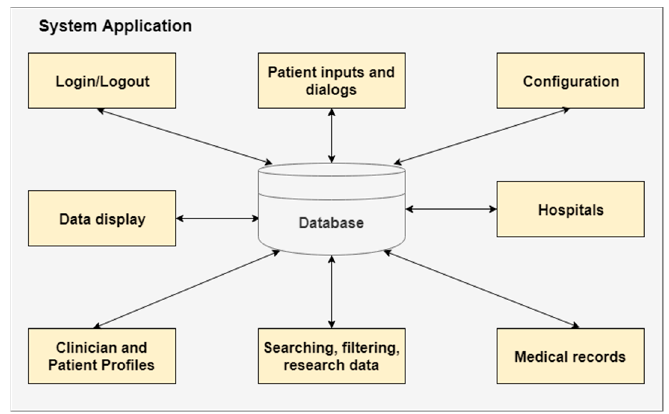
Figure 12. Overview of database responsibilities.